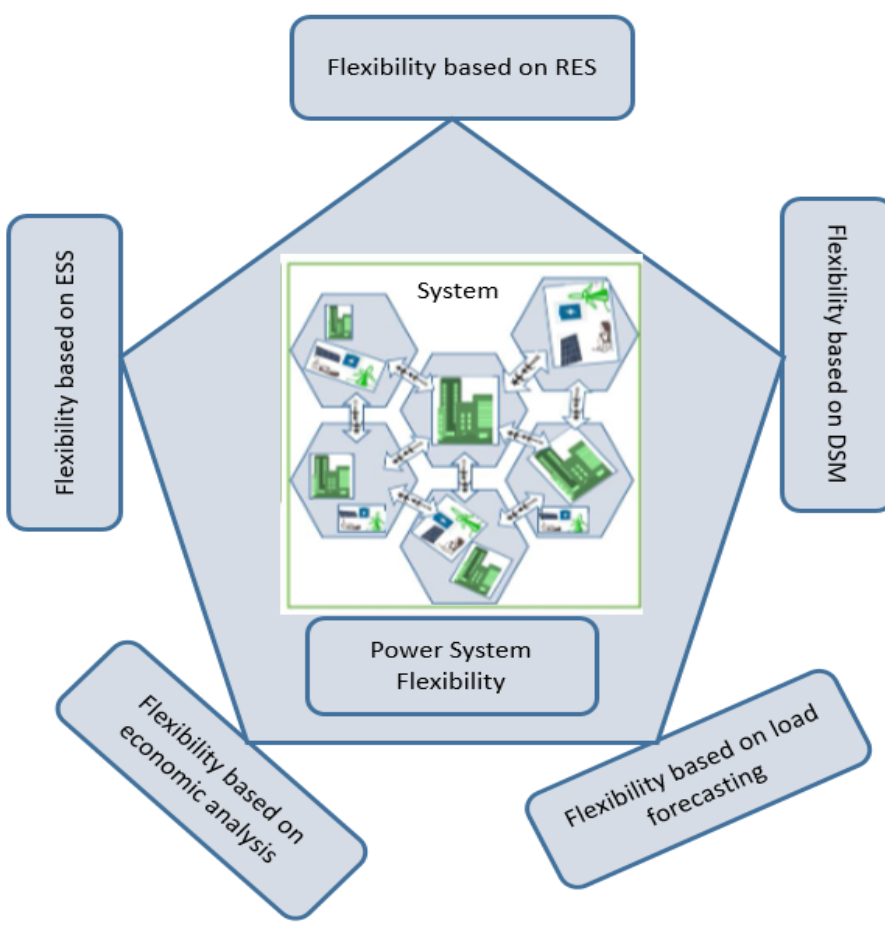
Figure 2. Approach to power system flexibility in this